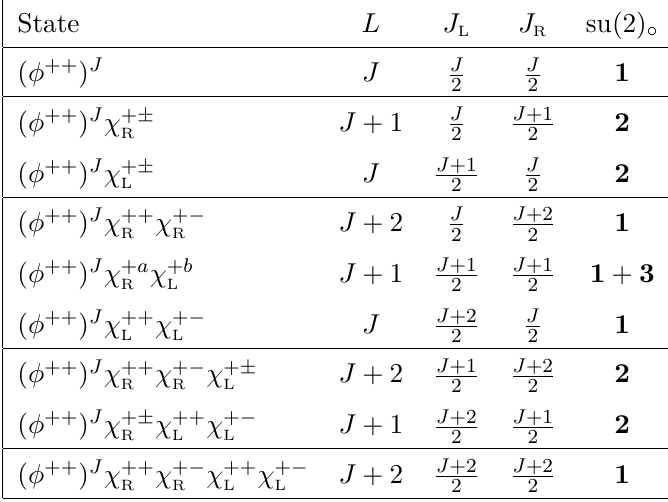
Table 4. The sixteen 1/2-BPS states containing J copies of the field φ ++ obtained by inserting the four fermionic zero modes. The length L of the corresponding spin-chain ground state and the charges under su(2) , su(2) and the su(2) ◦ representation are also L R